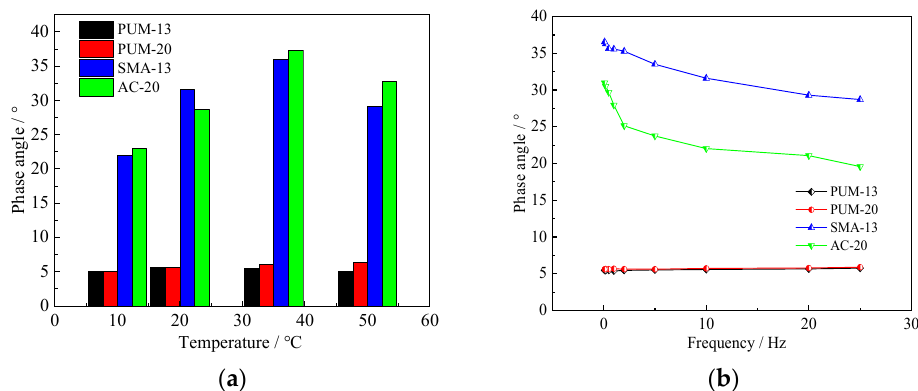
Figure 7. Phase angles of the four mixtures. ( a ) Dynamic modulus at 10 Hz frequency. ( b ) Dynamic modulus at 20 °C.